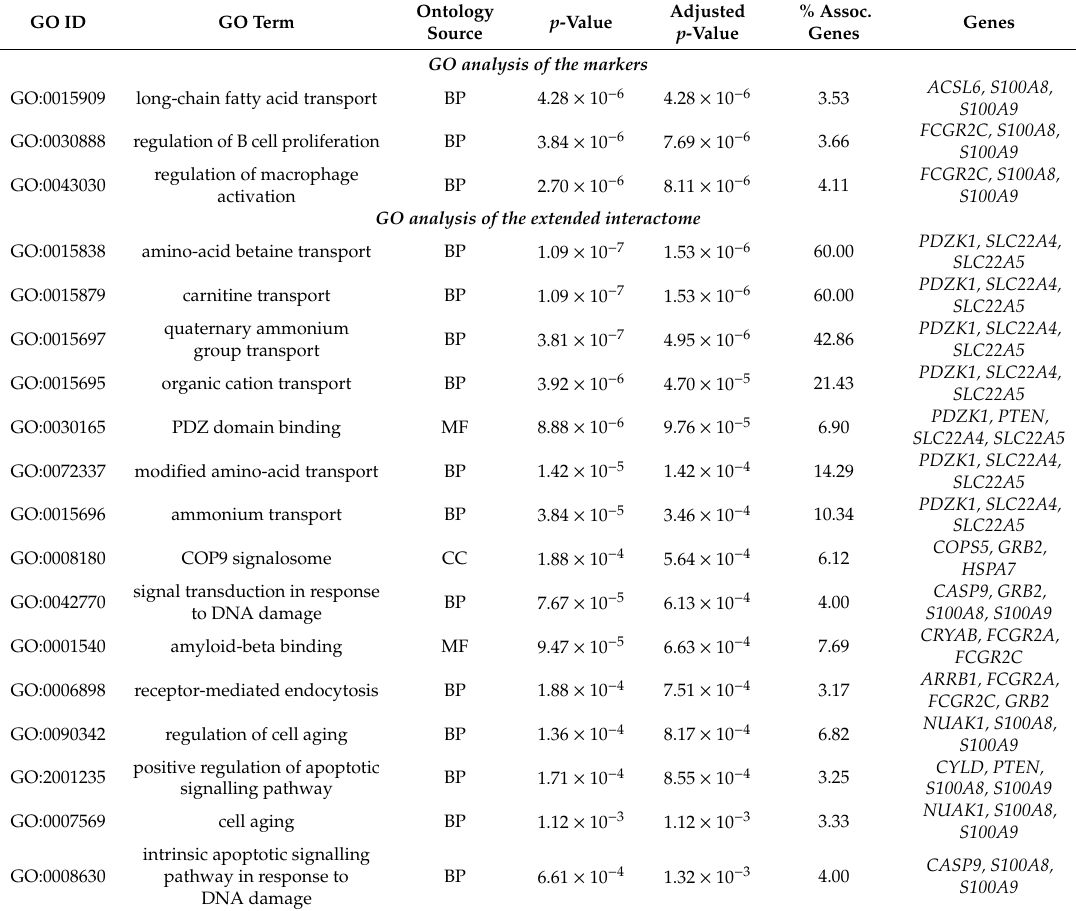
Table 5. GO analysis of the independently confirmed, integrated colonic markers linked to the short-term anti-TNF therapy response in CD